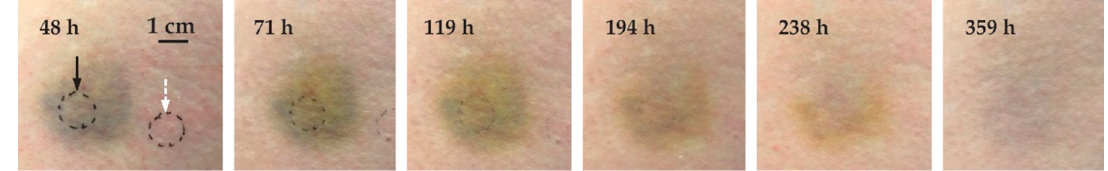
Figure 1. Photographs of the bruise in subject a at different times after the injury (see the labels), displaying the characteristic sequence of color changes. Dashed circles indicate the test sites on the bruised area and intact skin in its vicinity (black and white arrow, respectively).